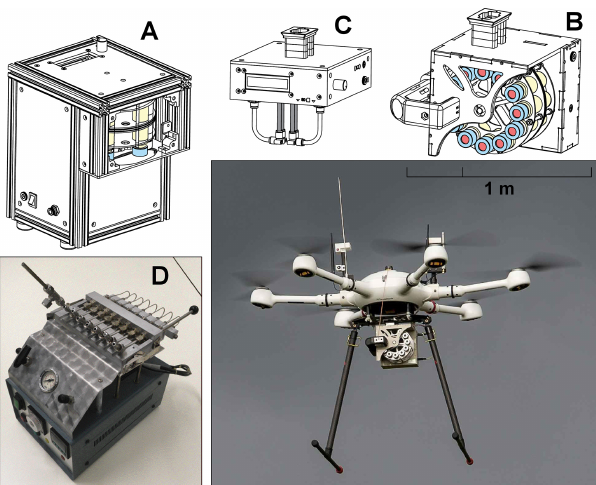
Figure 1. Overview of the sampling systems comprising of the vial preparation device (a) , the whole-air sampler (b) , the gas sampler for adsorbent tubes (c) , the sorbent tube conditioning device (Tube- Con2, d ) with one sorbent tube attached and the UAV applied in field tests equipped with the whole-air